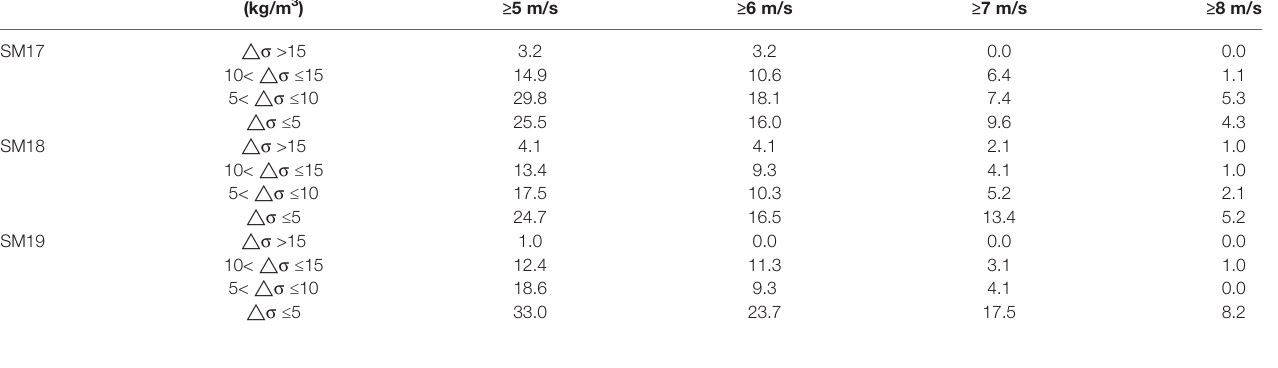
TABLE 3 (B) | The Accumulative Frequency (%) of △ s at different V7 Wind Speeds during 1990-2018 in summer. Group ≥ 5 m/s includes the other 3 groups, group ≥ 6 m/s includes the other 2 groups and so on. (kg/m 3 ) ≥ 5 m/s ≥ 6 m/s ≥ 7 m/s ≥ 8 m/s SM17 △ s >15